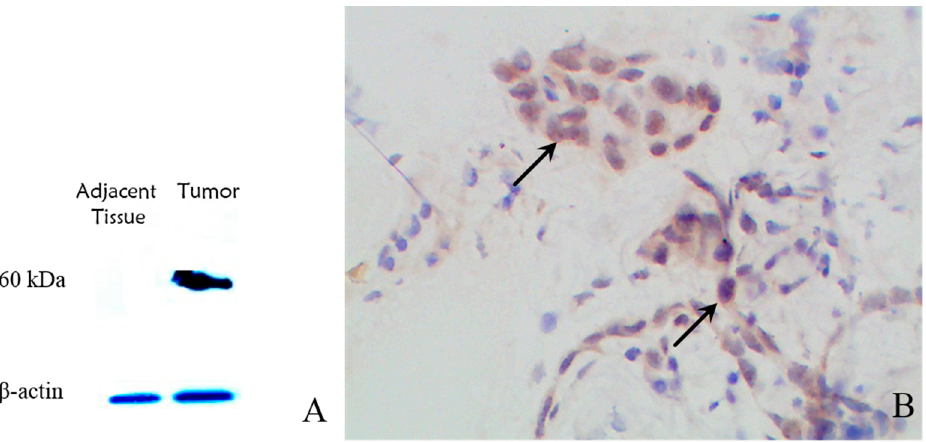
Figure 3. ( A ) Western blotting results showed a 60-kDa protein in tumor tissue correlating to the mutant truncated protein ( β -actin as internal control); ( B ) Immunohistochemistry results showed heavy staining of neoplastic cells (black arrows); magnification: 400×.